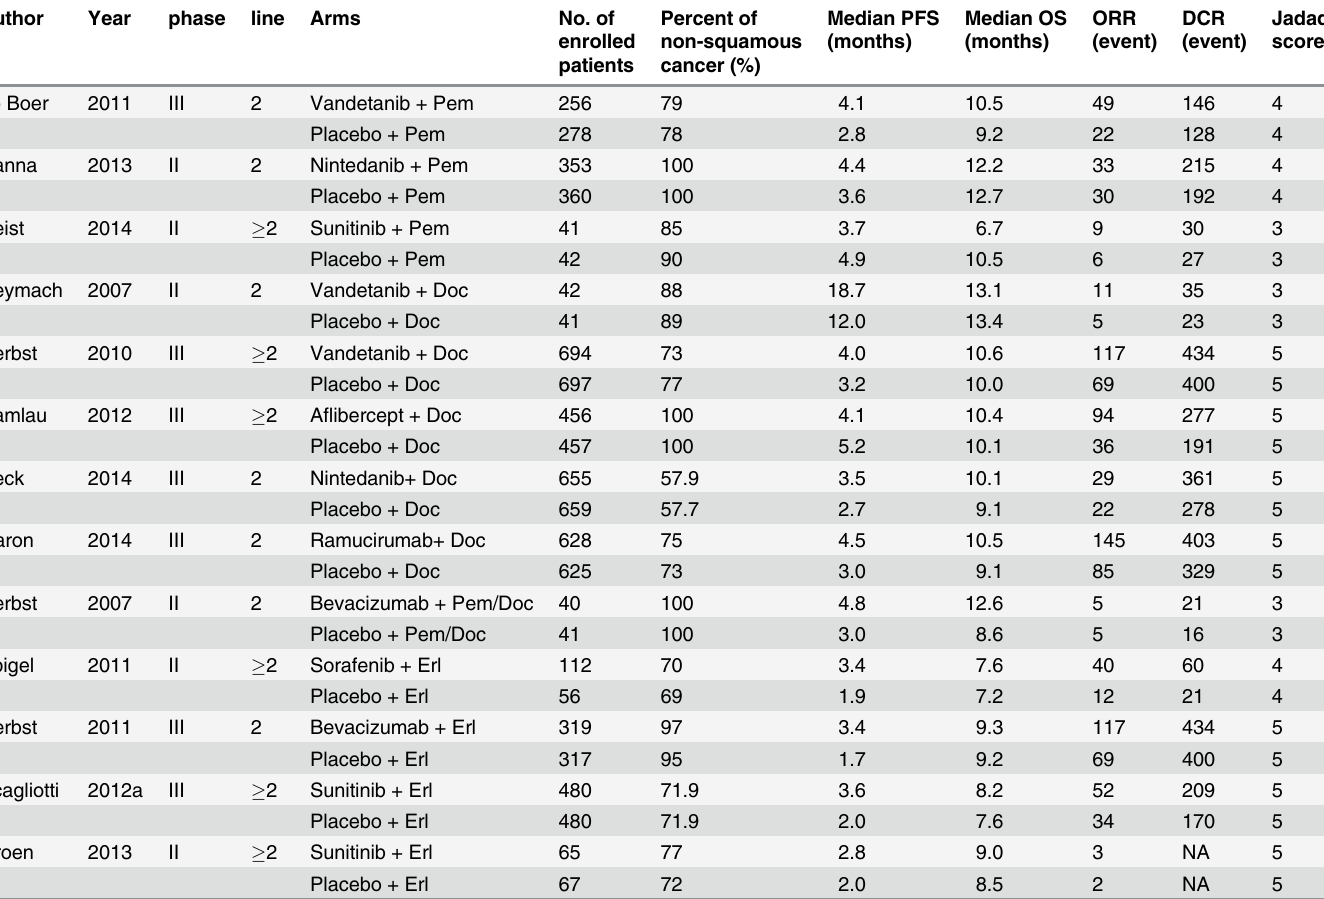
Table 1. Characteristics of included studies and